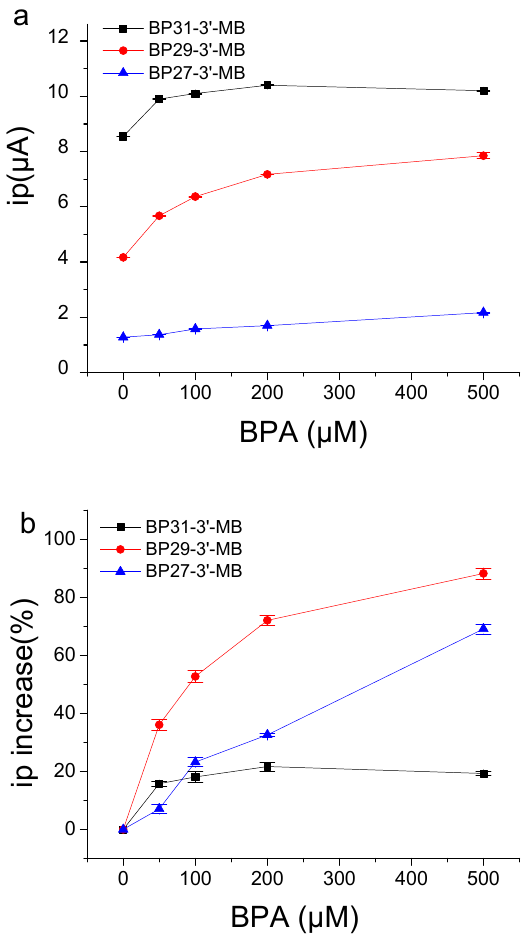
Figure 5. Responses of BP27-3’-MB-modified electrode, BP29-3’-MB-modified electrode, and BP31-3’-MB-modified electrode with respect to BPA. ( a ) Peak current (ip) values versus BPA concentrations. ( b ) Comparison of different aptamer-modified electrodes in the increased percentage in peak currents caused by BPA. The binding buffer contained 25 mM Tris-HCl (pH = 8.0), 100 mM NaCl, 25 mM KCl, and 10 mM MgCl 2 . Frequency was set as 250 Hz in SWV.